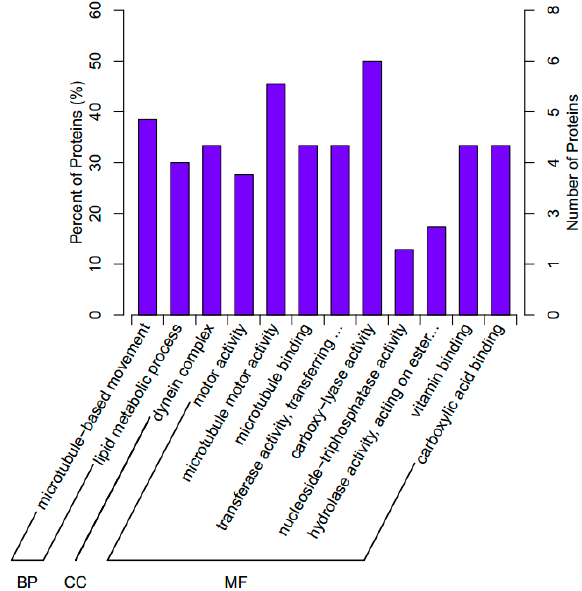
Figure 3. The Gene Ontology (GO) classifications assigned to the significant differentially expressed proteins in the abalone H. discus hannai . BP, biological processes; CC, cellular components; MF, molecular functions.